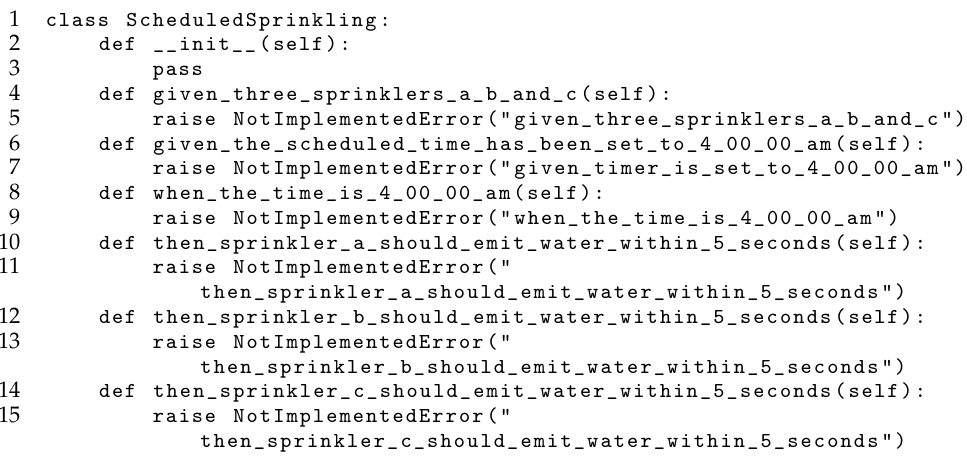
Figure 5. Scenario of scheduled sprinkling in concurrentSpec .